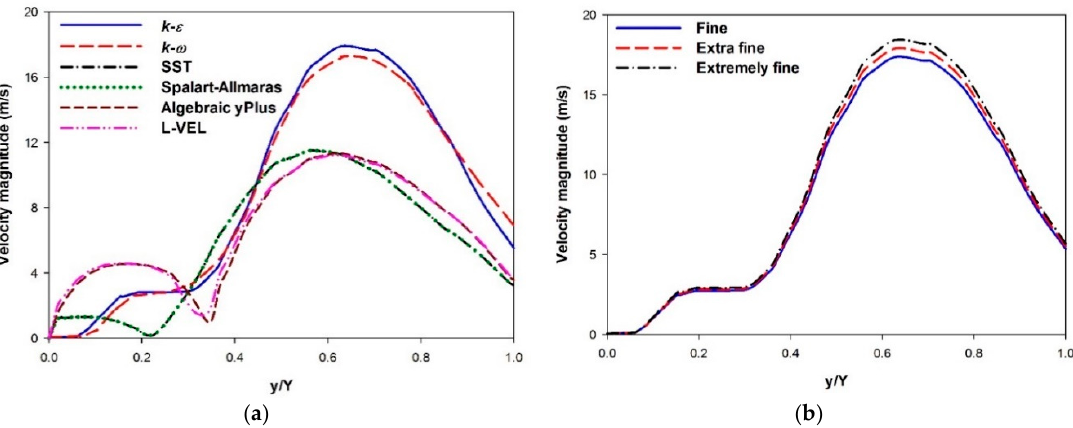
Figure 2. Comparisons of velocity magnitudes at point 1 for different ( a ) turbulence models and ( b ) mesh sizes at an air inlet velocity of 35 m/s and bed slanting angle ( θ ) of 0°.